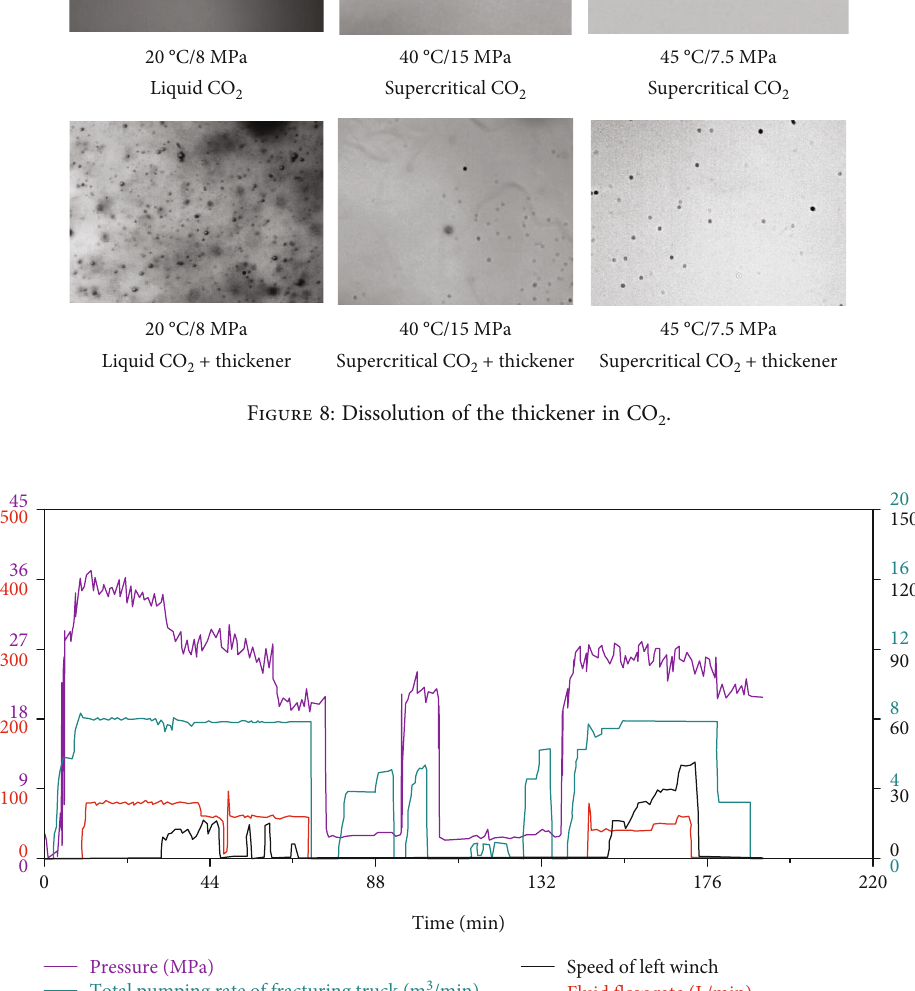
Figure 9: Dry fracturing operation curve of Well Hong